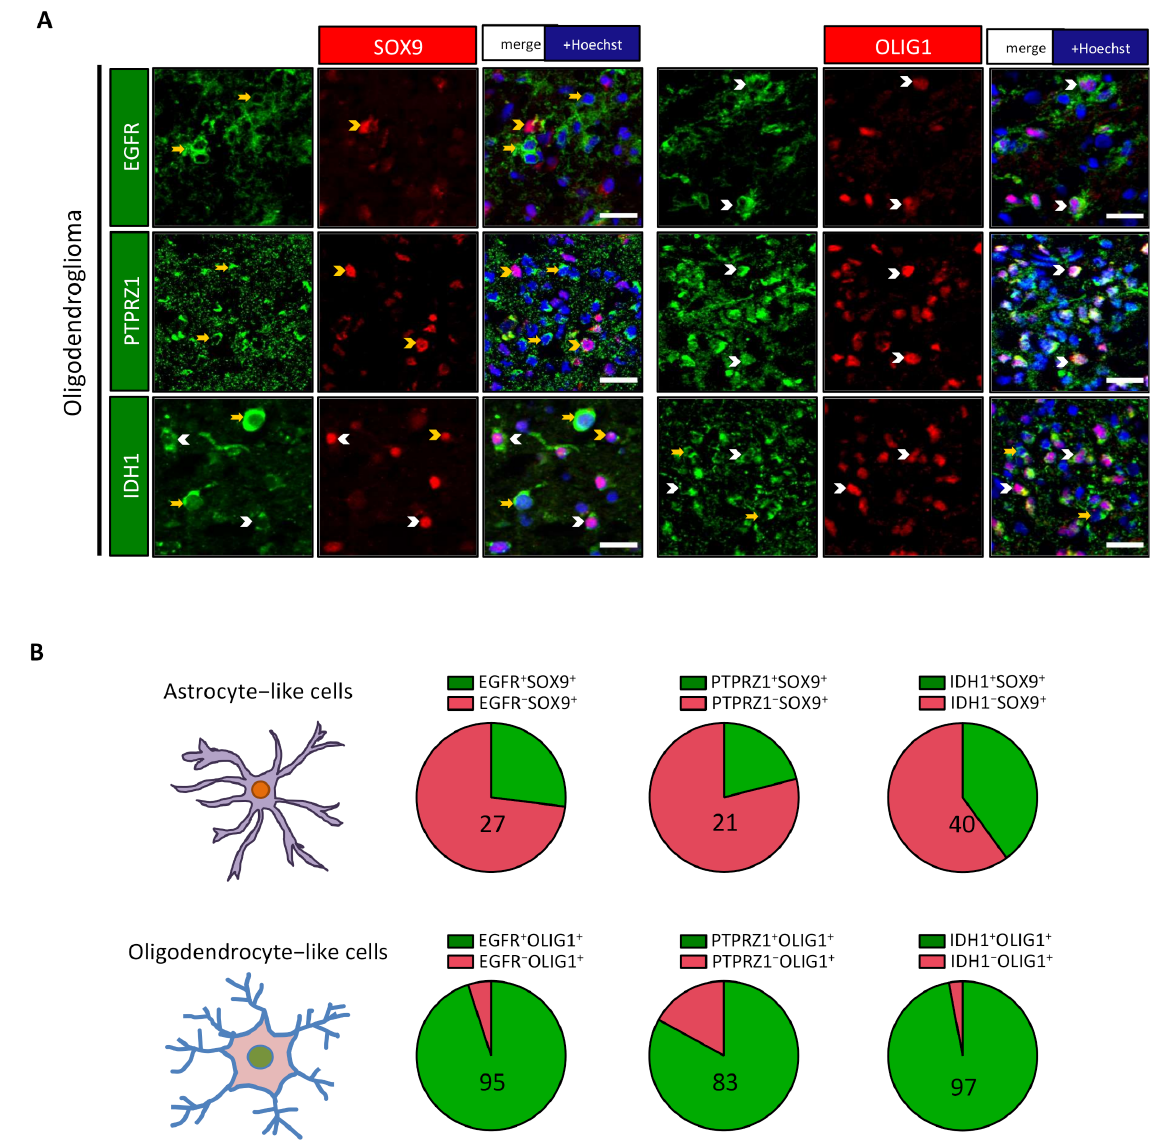
Figure 4. OLIG1 + cells express specific receptors and IDH1. ( A ) Double immunofluorescences in one oligodendroglioma for EGFR, PTPRZ1, and IDH1 with SOX9 and OLIG1 revealed their preferential expression with OLIG1 + cells. White arrowheads identify double-positive cells, while yellow arrowheads/arrows represent single-positive cells. Scale bars = 20 µ m. ( B ) Pie diagrams representing the percentage of double-positive (green) and single-positive (red) cells in SOX9 + and OLIG1 + cells. Numbers indicate the percentage of double-positive